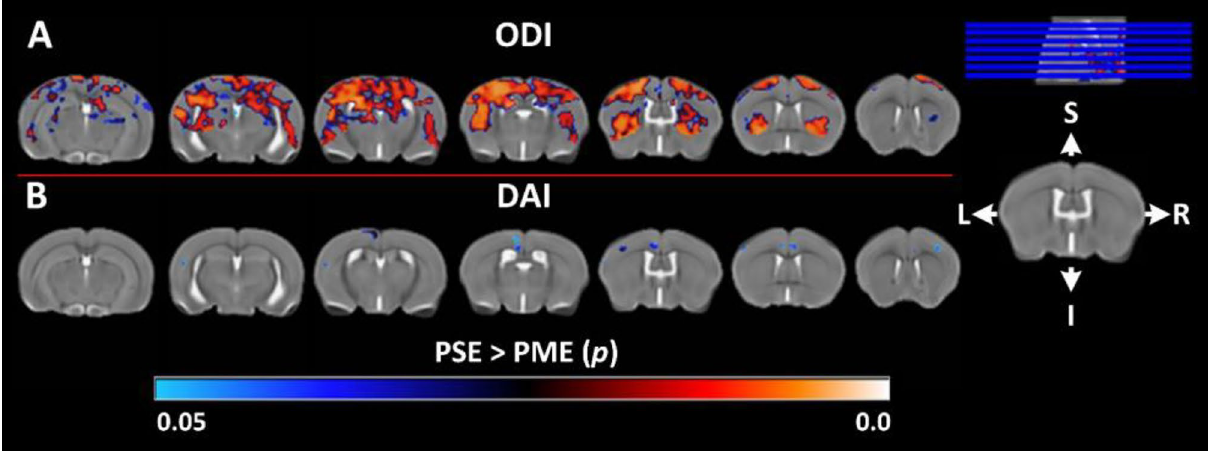
Figure 4. Voxel-wise statistical maps using NODDI derived parametric maps. Clusters depicted in false color indicate regions where PSE (n = 15) animals exhibited significantly higher values compared to PME (n = 15). The results were family-wise error corrected for multiple comparisons ( p < 0.05). Variation in color maps highlight the degree of significance. The results are overlayed on a study specific b0 template (a T2W template) for better visualization. ODI: orientation dispersion index and DAI, dispersion anisotropy index. L and R indicate anatomical orientation: Left–Right. S and I indicate anatomical orientation: